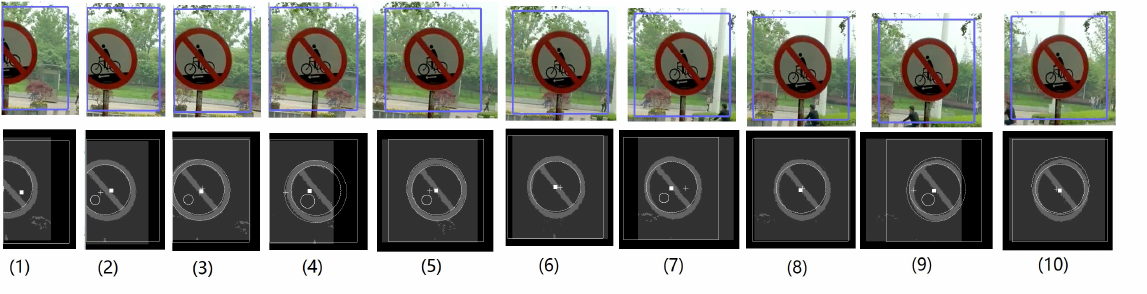
Figure 14: Coarse Prediction Results In a Video